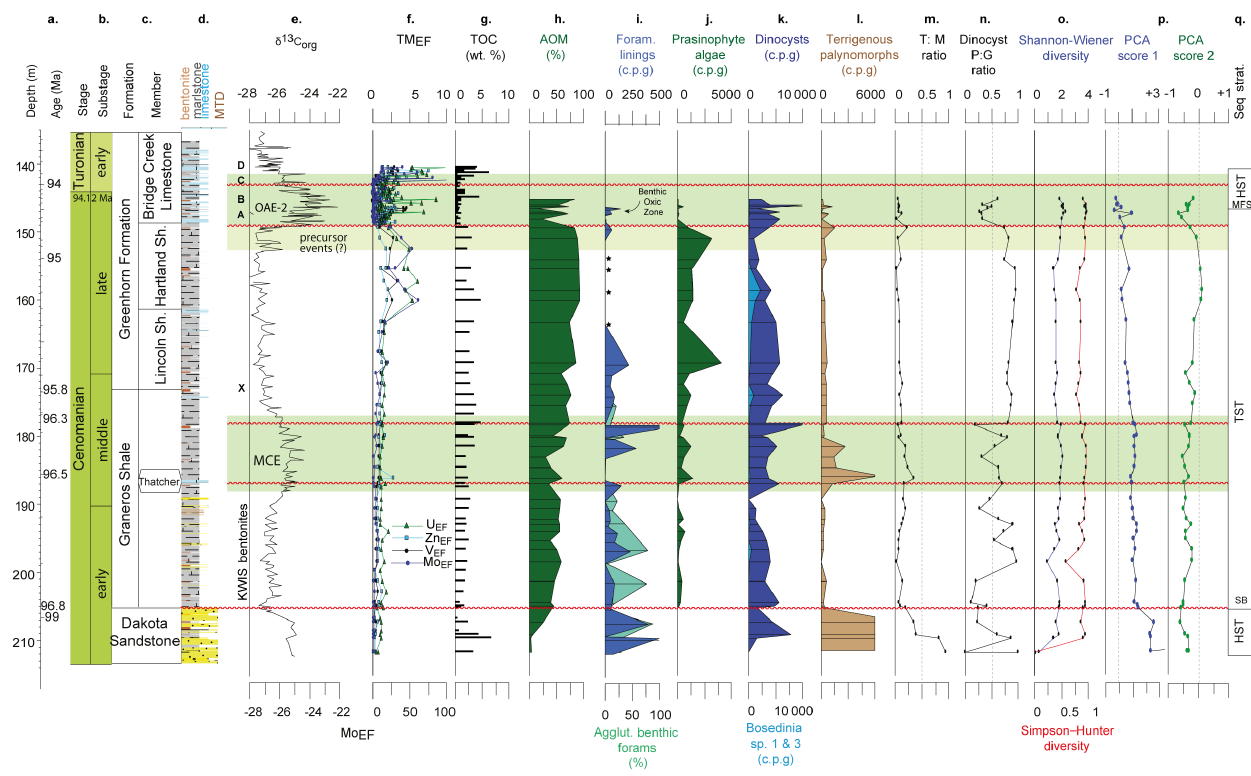
Figure 8. USGS Portland-1 core data. Legend same as Fig. 4. δ 13 C org data from Joo and Sageman (2014), Eldrett et al. (2014), Du Vivier et al. (2014), Eldrett et al. (2015a) and this